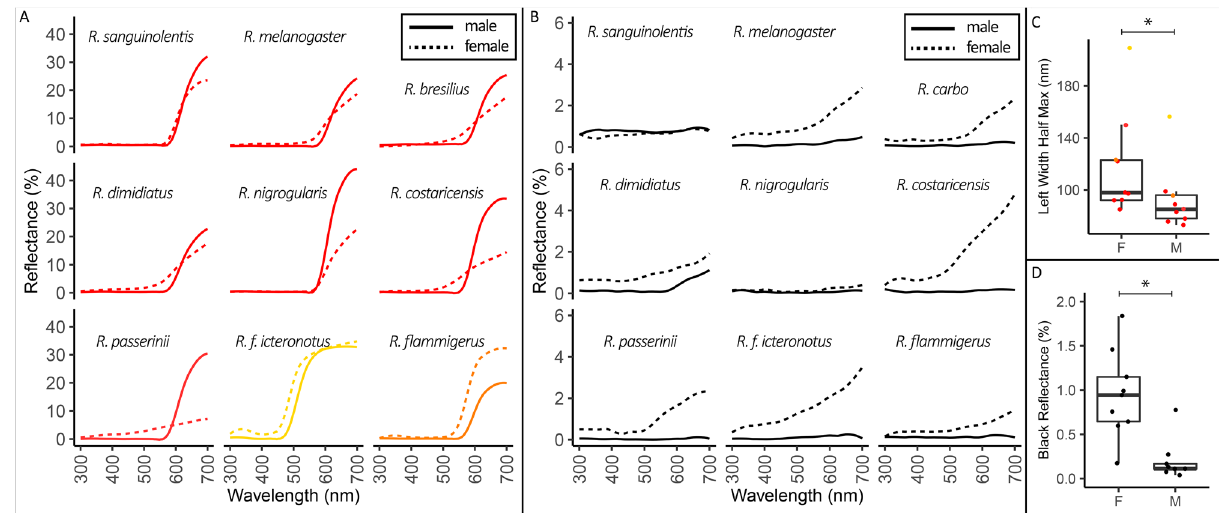
Figure 2. Male Ramphocelus tanagers have significantly more saturated colors and darker blacks than females. Spectrophotometry results for 90° incident light. ( A ) Males (solid lines) have brighter and more saturated colors for all species except R. flammigerus and R. f. icteronotus . We included the body region of each male and female with the max reflectance, which was rump for all species except male R. sanguinolentis (crown), male R. bresilius (crown), female R. bresilius (stomach), female R. dimidiatus (stomach), female R. costaricensis (breast), and female R. passerini (throat). We excluded R. carbo from this plot, because it is dark red rather than brilliant; N = 9. ( B ) Males (solid lines) have a darker black color, with a flatter reflectance curves, on their backs compared to females (dashed lines) for all species except R. sanguinolentis . We measured the black back of each species except R. dimidiatus , for which we measured the black throat. We excluded R. bresilius , which is all red except for its tail and wings; N = 9. ( C ) For a measure of saturation, leftwards width at half maximum reflectance, males had significantly more saturated color than females (phylogenetic two-sample paired t-test; p-value = 0.0072, 95% CI: [13.0, 38.1]). Narrower peaks (i.e., smaller value for left width at half maximum reflectance), indicate a more saturated color. ( D ) For a measure of darkness, total integrated reflectance under the curve, males had significantly darker black regions than females (phylogenetic two-sample paired t-test; p-value = 0.0066, 95% CI: [0.38, 1.11]). Complete spectrophotometry results are in Supplemental Data 1. Integration time was 100 ms, and each line in the spectra ( A , B ) and point in the boxplots ( C , D ) represents the average of three replicates within the same plumage